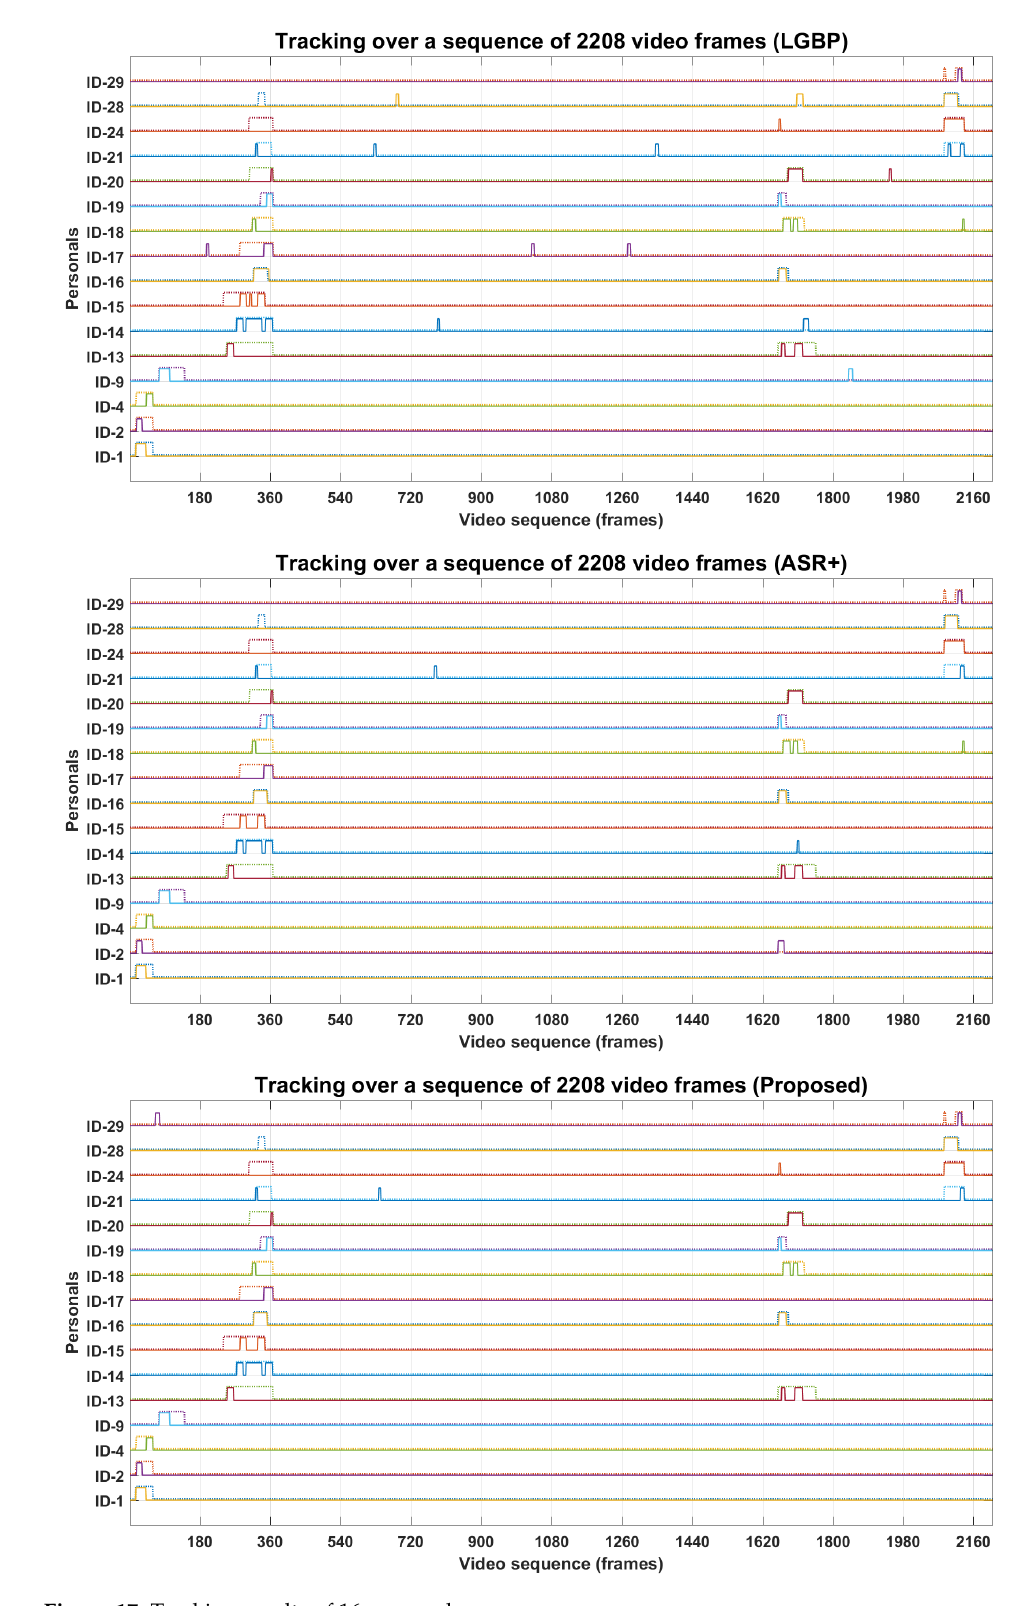
Figure 17. Tracking results of 16